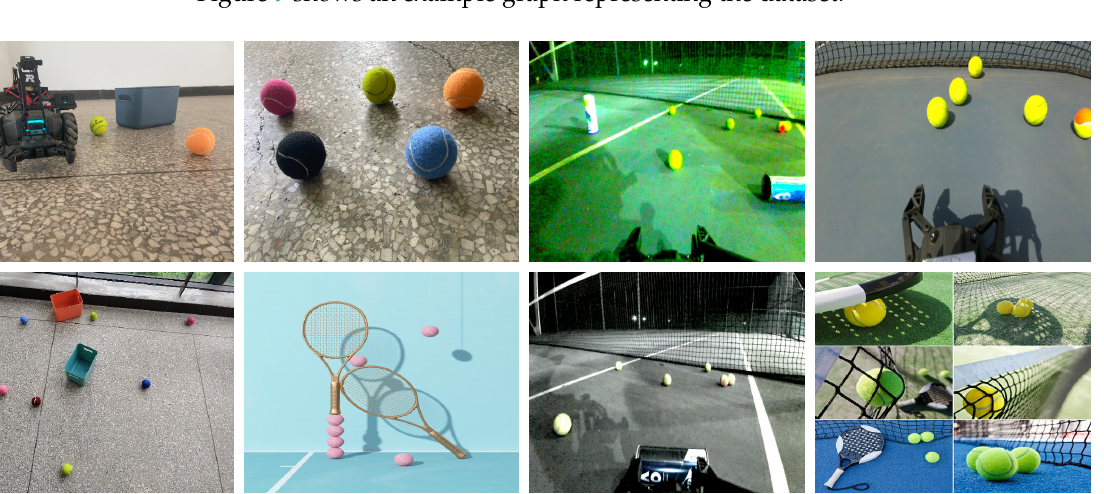
Figure 9. Representative